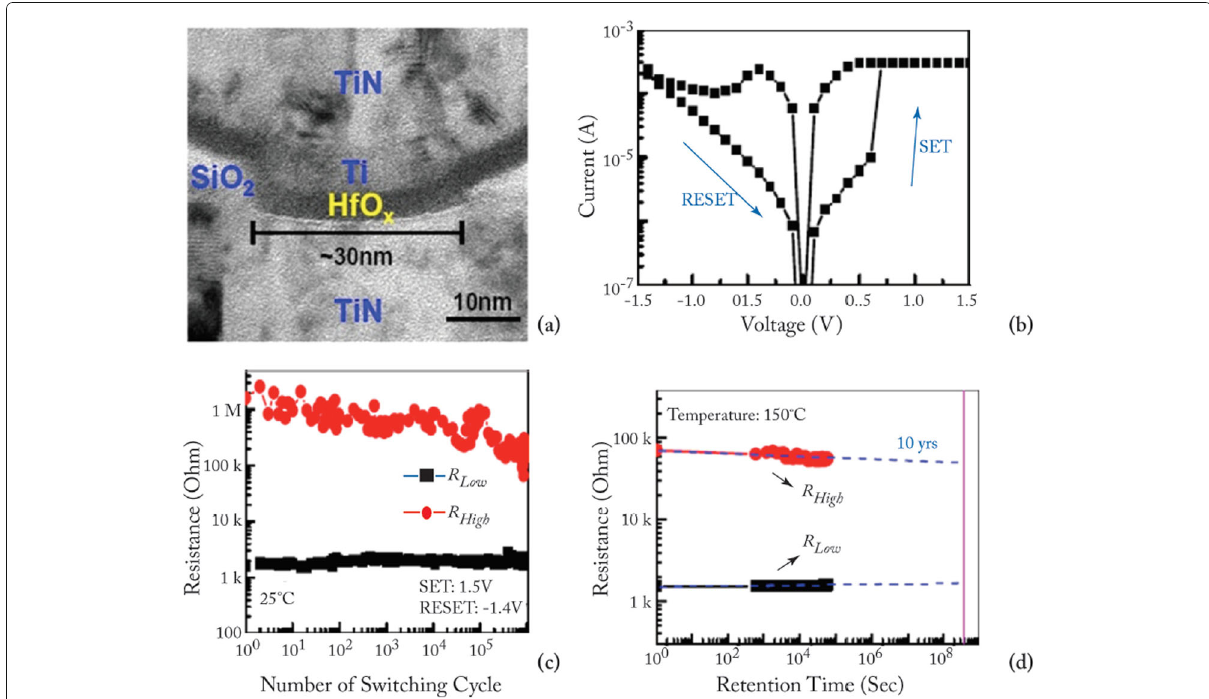
Fig. 7 a Transmission electron microscopy (TEM) image of TiN/Ti/HfO x /TiN RRAM device. b Typical current-voltage (I-V) characteristics of the device with 30-nm cell size. c 10 6 endurance switching cycles obtained from 500 μ s pulse. d A retention lifetime of 10 years is expected by testing at 150 ◦ C ; reprinted from refs. [81,